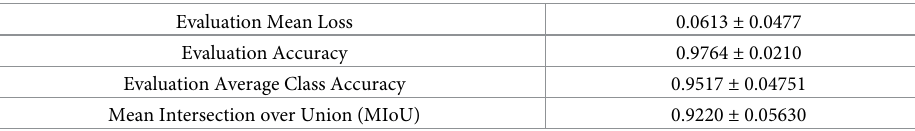
Table 2. Performance results of